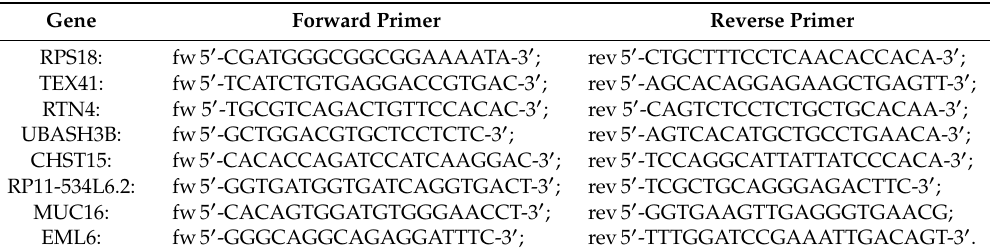
Table 2. List of RT–qPCR